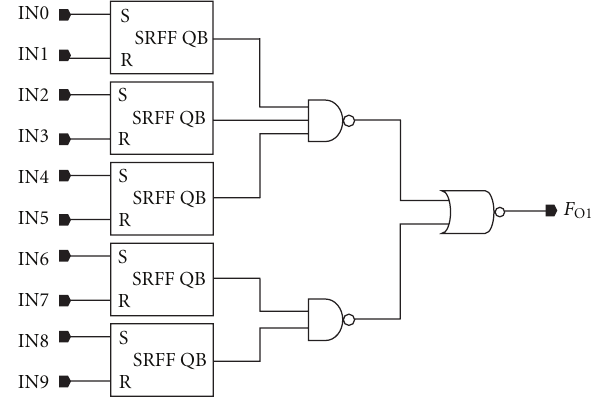
Figure 20: Block diagram of EC for DLL1.